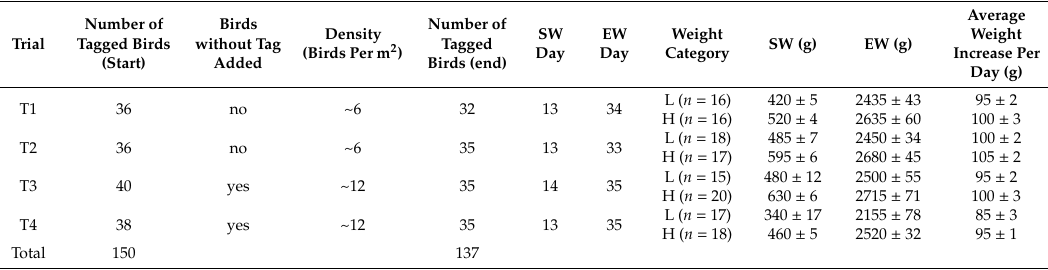
Table 1. Overview of sample sizes, densities, measurement days, weights (mean ± SEM; SW = start weight, EW = end weight) and average weight increase (mean ± SEM) for the activity trends study. The weights are separated for the two weight categories (L = light; H = heavy). Weights of individual birds were determined with five-gram precision and reported averages are rounded to five-grams. SEMs are rounded to round